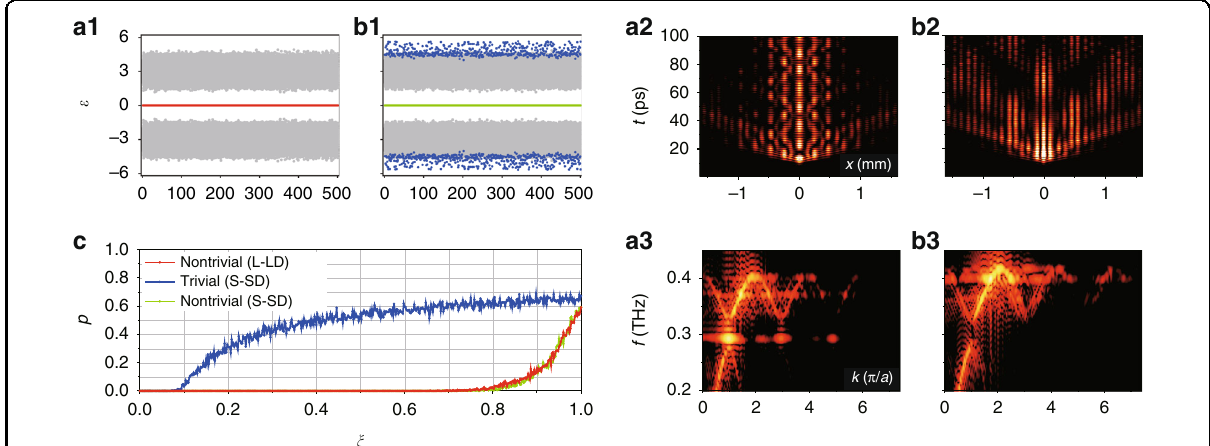
Fig. 4 Distinction between topologically nontrivial and trivial defect modes under chiral perturbations. a1 Calculation of the eigenvalue distribution ε under 500 sets of off-diagonal perturbations in the L-LD structure. The red dots (forming a line) represent the eigenvalues associated to the topological mode and the gray dots show the distribution of the bulk modes. a2 Simulation of the x − t diagram for the central defect excitation under perturbations. a3 The corresponding spectrum of ( a2 ). b1 – b3 have the same layout as ( a1 – a3 ) but for the S-SD structure, where green and blue dots denote nontrivial and trivial defect modes, respectively. c Plot of p versus perturbation strength ξ , where p ¼ n bulk = n all , with n bulk de fi ned as the number of perturbation sets that result in coupling of the trivial defect mode with the bulk modes and n all as the total number of perturbation sets (in this case n all ¼ 500). Red and green lines illustrate the nontrivial modes in the L-LD and S-SD structures, respectively, while the blue line is for the trivial defect mode in the S-SD